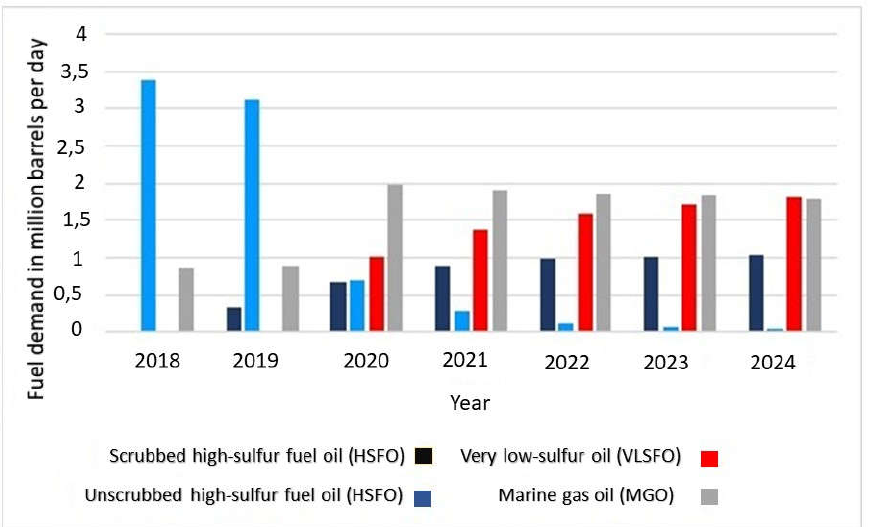
Figure 1. Daily global marine bunkers consumption. Source: [3].